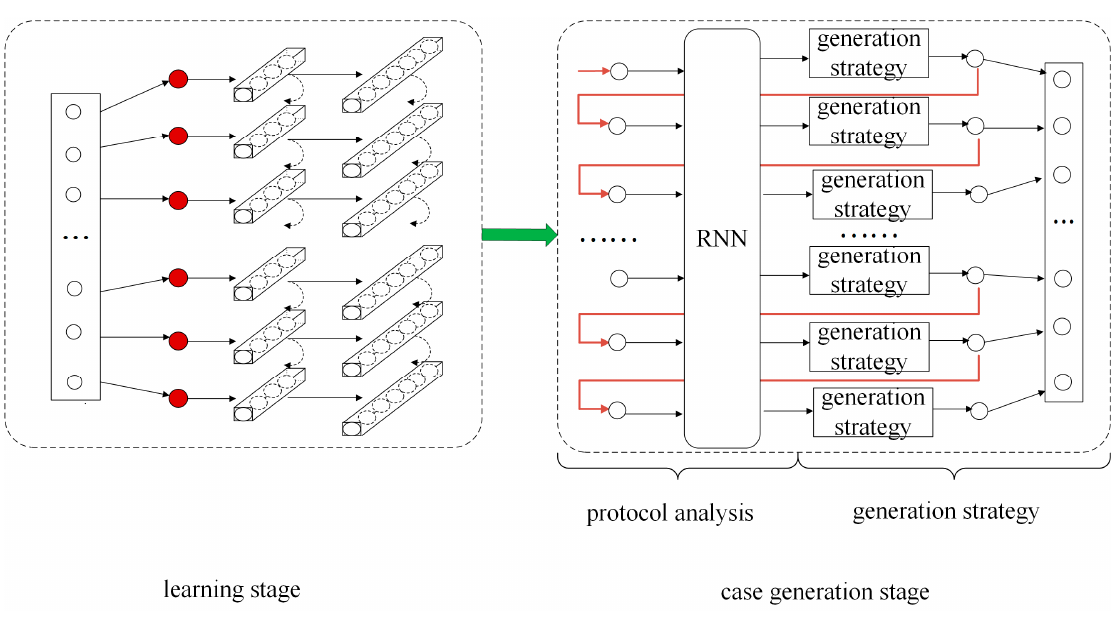
Figure 6. The construction of learning messages and the conversion process of data values in Modbus TCP.